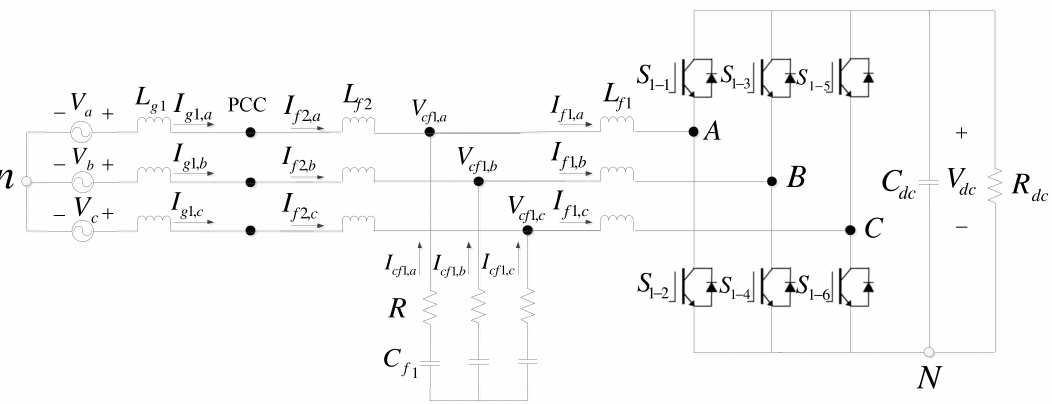
Figure 4. Configuration of the grid